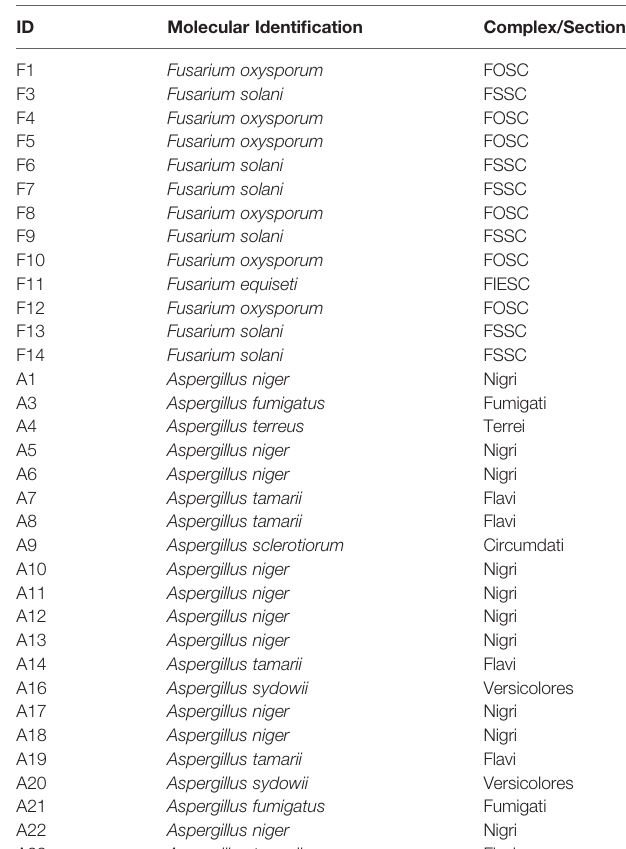
TABLE 2 | Molecular identi fi cation of species of Fusarium and Aspergillus .